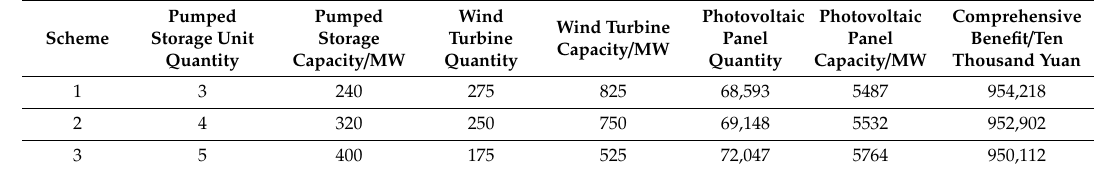
Figure 9. Strategy 1 and 2: comprehensive income comparison. Table 2. Wind farm, PV, pumped storage capacity allocation and comprehensive benefit statement.